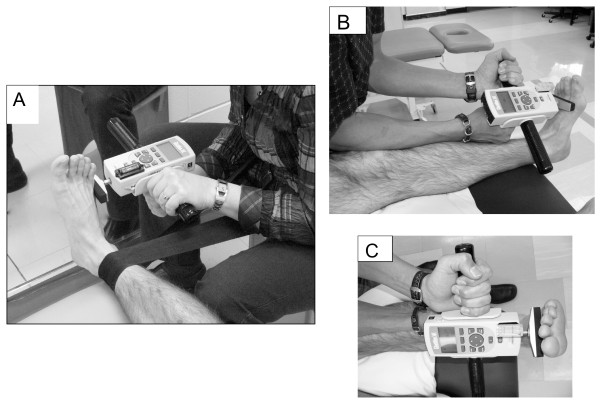
The maximum isometric muscle strength of the ankle evertors (A) and dorsiflexors (B and C) was assessed with a Chatillon push-pull hand-held dynamometer. The positioning of the subject was standardised ensuring that «gravity eliminated» positions were used for each muscle group.